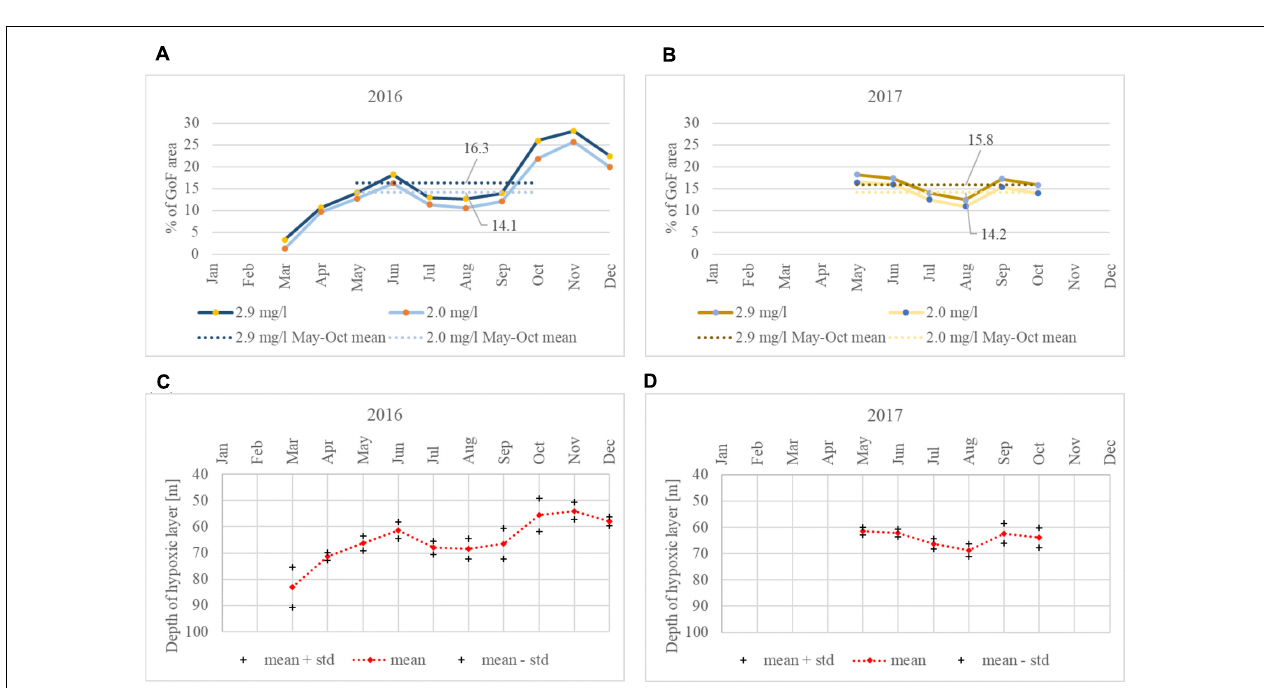
FIGURE 6 | Monthly mean extent of the hypoxic area in the GoF [ (A) : DO < = 2.9 mg · l − 1 and DO < = 2.0 mg · l − 1 in 2016, (B) : 2017]. Monthly mean hypoxic (DO < = 2.9 mg · l − 1 ) depth values in 2016 (C) and 2017 (D) .